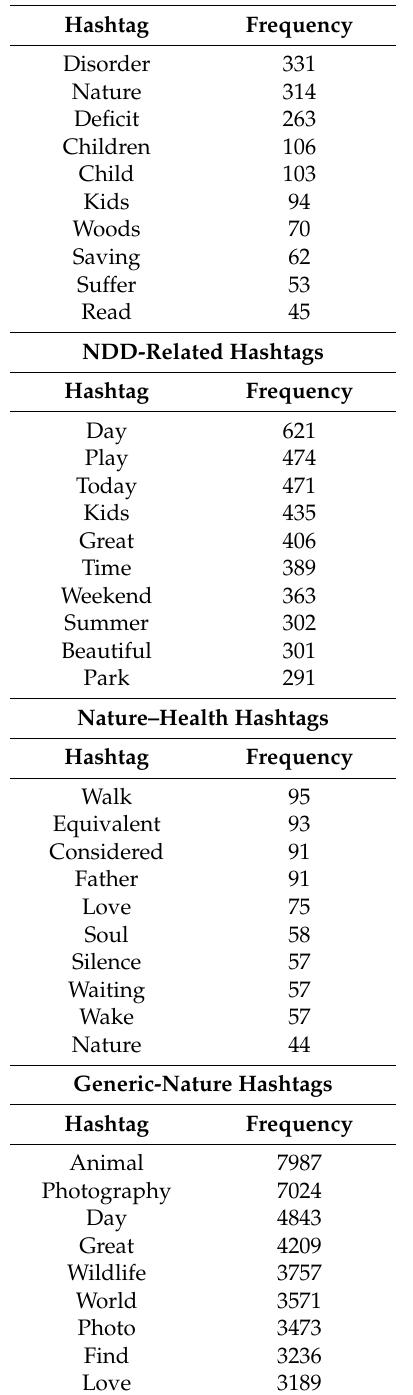
Table 11. Most frequent words contained in the tweets. NDD